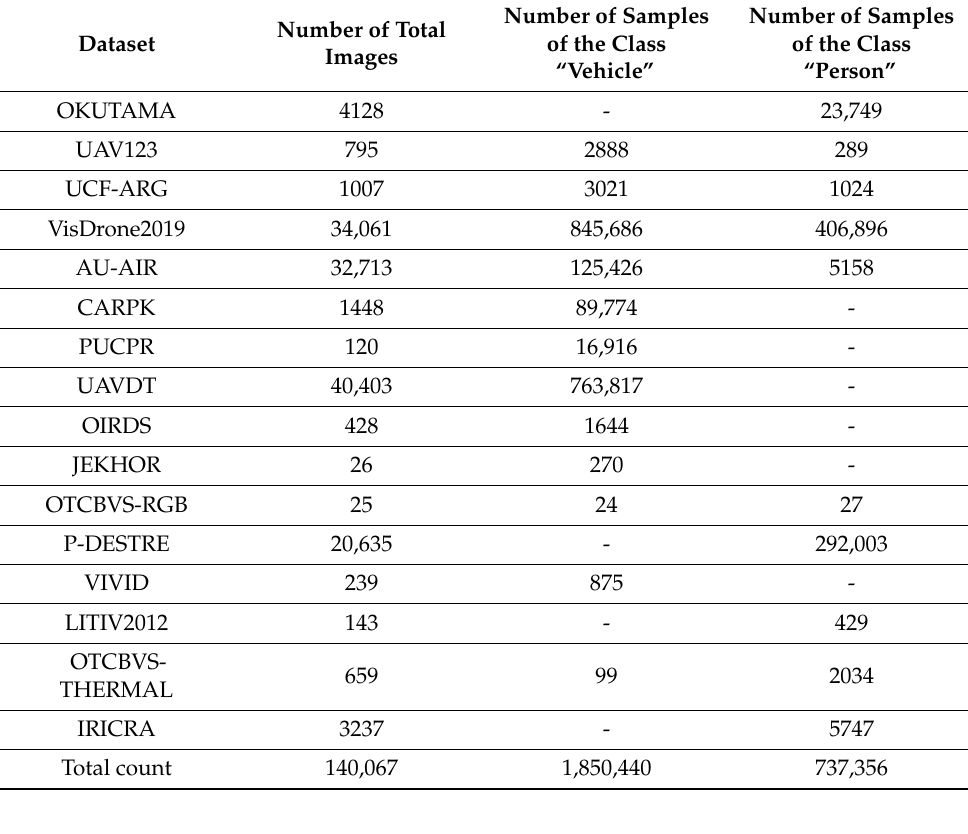
Table 3. Detailed information for the datasets used for the custom YOLOv3.